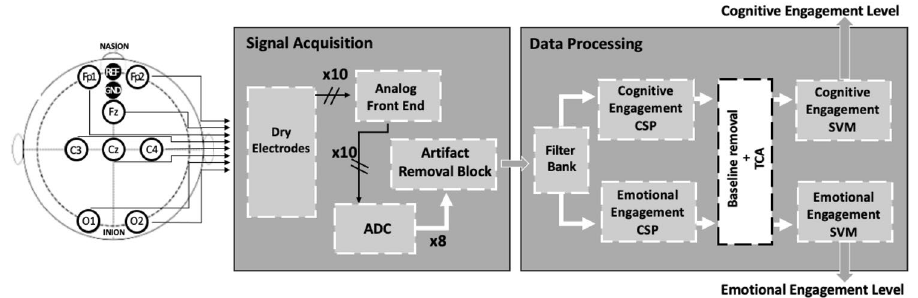
Figure 1. The architecture of the system for engagement assessment; the white box is active only in the cross- subject case (ADC-Analog Digital Converter, CSP-Common Spatial Pattern, TCA-transfer component analysis, and SVM-support vector